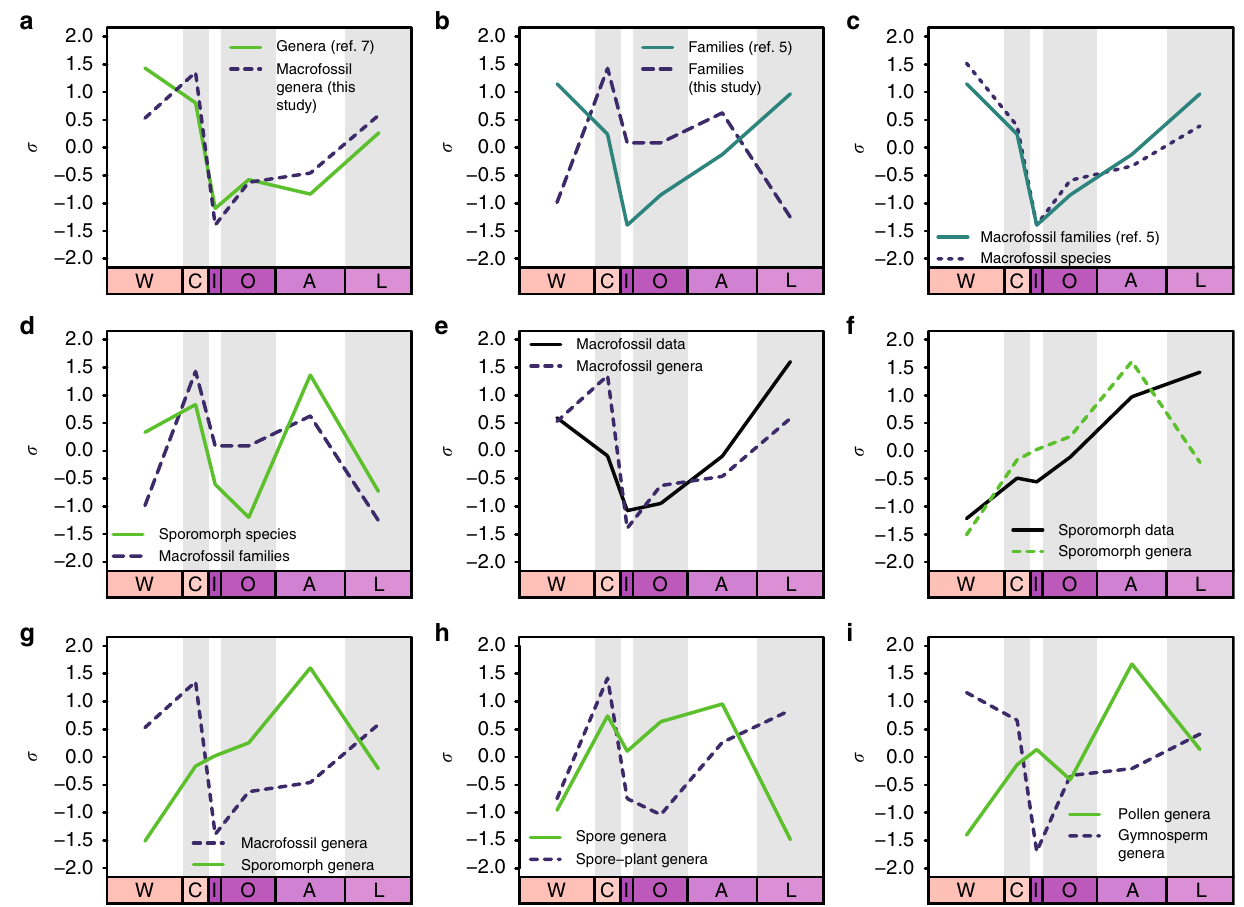
Fig. 5 Comparison of results after mean-centreing and scaling to the standard deviation ( σ ). W = Wuchiapingian, C = Changhsingian, I = Induan, O = Olenekian, A = Anisian, L = Ladinian. a Total diversities of macrofossil genera in this study and ref. 7 , showing similar trends, except across the Wuchiapingian to Changhsingian transition. b Plant families presented in the present study and in ref. 5 , showing conspicuous differences. c Total diversities of macrofossil species presented in this study and plant families presented in ref. 5 ; note that the curves are almost congruent, despite the differences at the family level shown in b . d Total diversities of sporomorph species and plant macrofossil families, exhibiting broadly similar trends. e Macrofossil data entries and macrofossil genera; note the similarity with the exception of a peak in generic diversity in the Changhsingian. f Microfossil data entries and microfossil genera; these are well-correlated except for a signi fi cant decline in the number of genera towards the Ladinian despite an abundance of data. g Plant macrofossil and microfossil genera, exhibiting very different trends. h Genera of spores and spore-plant macrofossils, showing several key similarities; compare with i . i Pollen and gymnosperm macrofossil genera, showing almost perfectly opposite trends; compare with